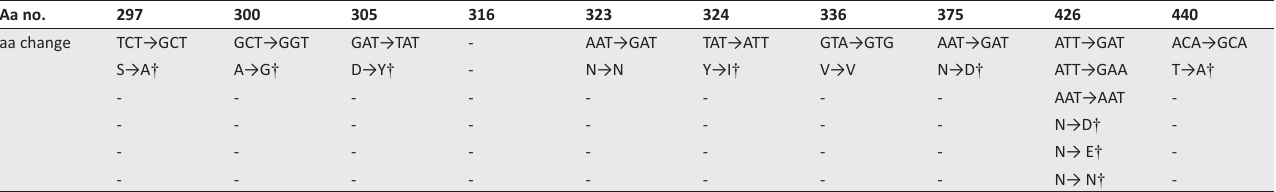
Note: Homologous amino acid by sign (-). TABLE 3b: Amino acid changes in VP2 partial gene of canine parvovirus-2a, canine parvovirus-2b and canine parvovirus-2c. Aa